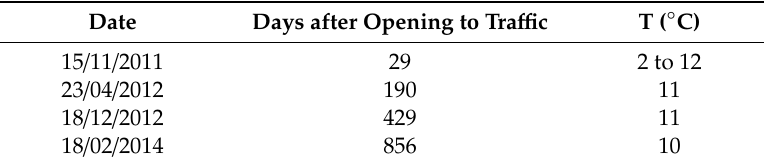
Table 2. Details of the experimental campaign conducted on motorway A10 in France [44].